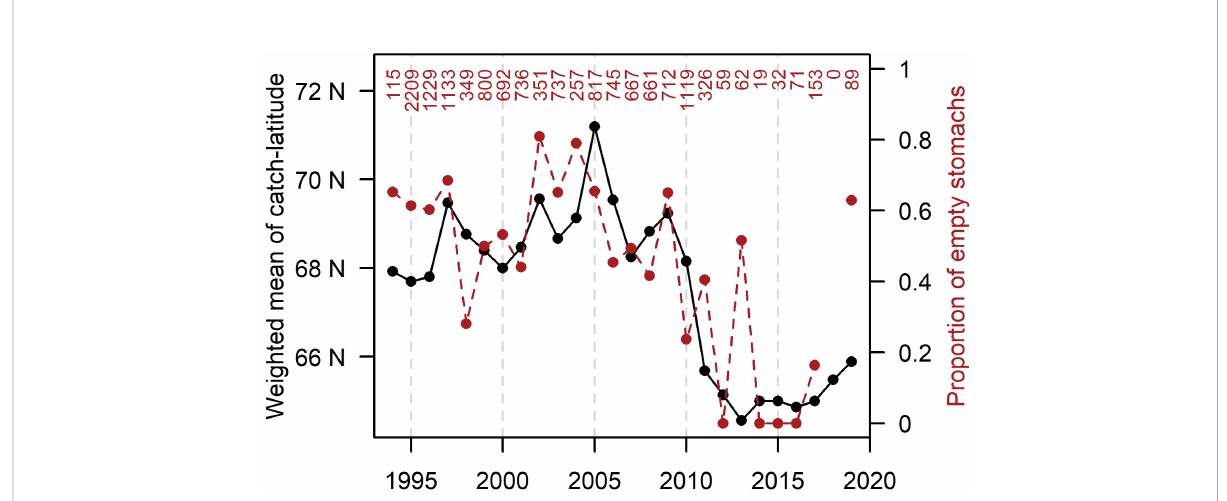
FIGURE 8 Interannual development of weighted average catch latitude (from combined Norwegian, Faroese and Icelandic fl eets) and proportion of empty stomachs (based on Norwegian samples) in August-September. Number of fi sh analysed for stomach fullness per year is indicated at the